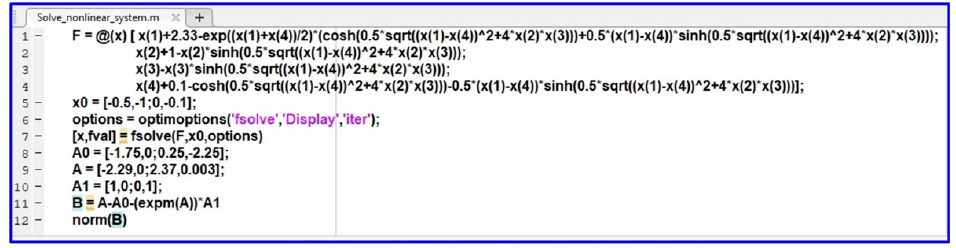
Figure A1. MATLAB implementation of the algorithm for the transcendental matrix equation with dimension = 2.